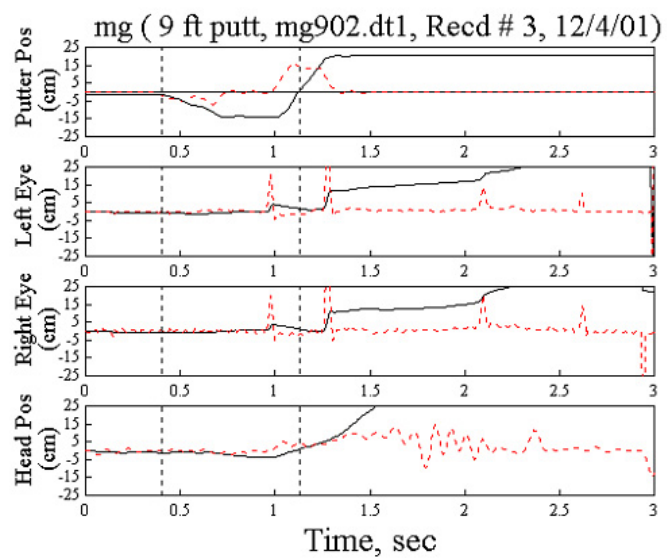
Figure 9B . Time traces for a typical 9-ft putt using the cross-hand grip. Sub.